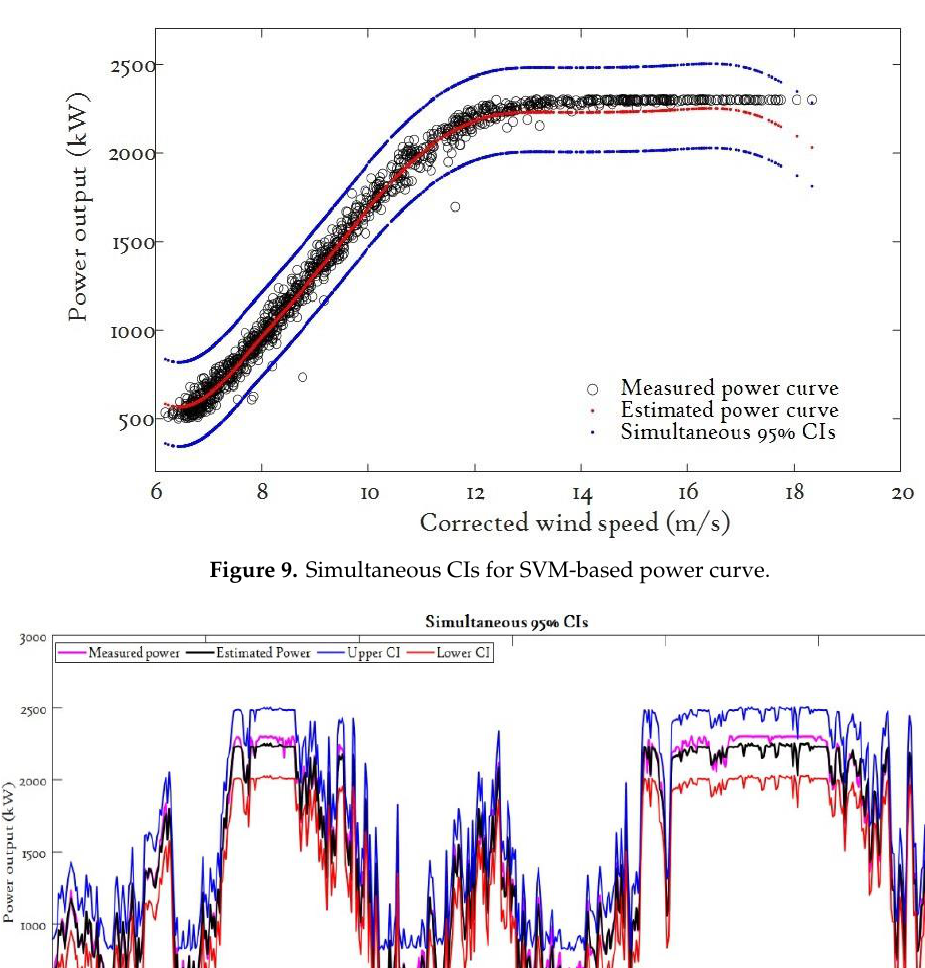
Figure 8. Analysis of pointwise CIs for estimated power values in time-series.